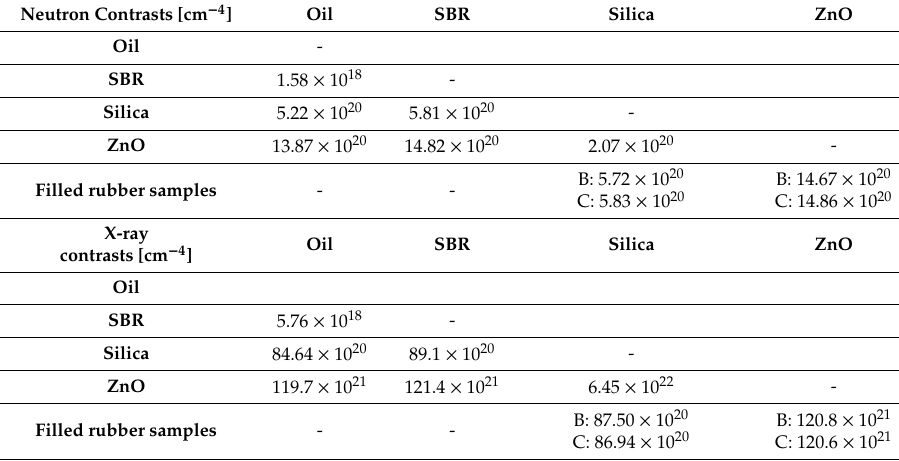
Table 4. Contrasts for SANS and SAXS